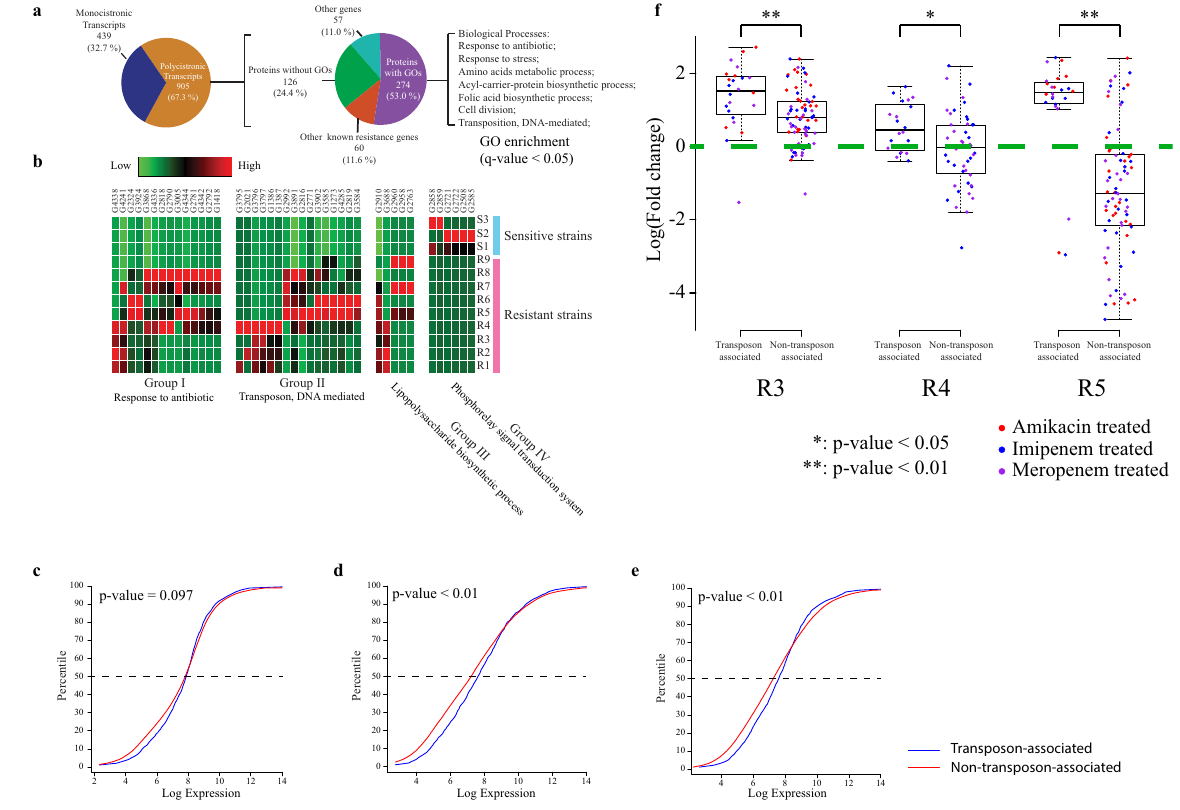
Figure 4. Transposons were up-regulated in multidrug-resistant strains and their associated genes maintained relatively higher expression in antibiotic-treated environments. ( a ) Statistics of genes co-transcribed with known antibiotic resistance genes. ( b ) Heat map of differentially expressed genes between multidrug-resistant strains and -sensitive strains, classified by functional groups. ( c – e ) Comparison of percentile-of-expression values between transposon-associated genes and non-transposon-associated genes at antibiotic-free mid-log phase ( c ), antibiotic-treated mid-log phase ( d ), and antibiotic-treated stationary phase ( e ). Blue line represents transposon-associated genes; red line represents non-transposon-associated genes. p -values were calculated by Wilcoxon’s rank-sum test. ( f ) Boxplots of fold changes of known antibiotic resistance genes under the antibiotic treatments. Each point represents a log(fold change) value of a known antibiotic resistance gene under a certain antibiotic treatment. p -values were calculated by Wilcoxon’s rank-sum